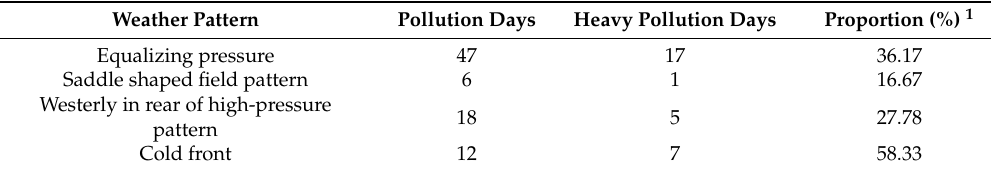
Table 3. Pollution days for different weather